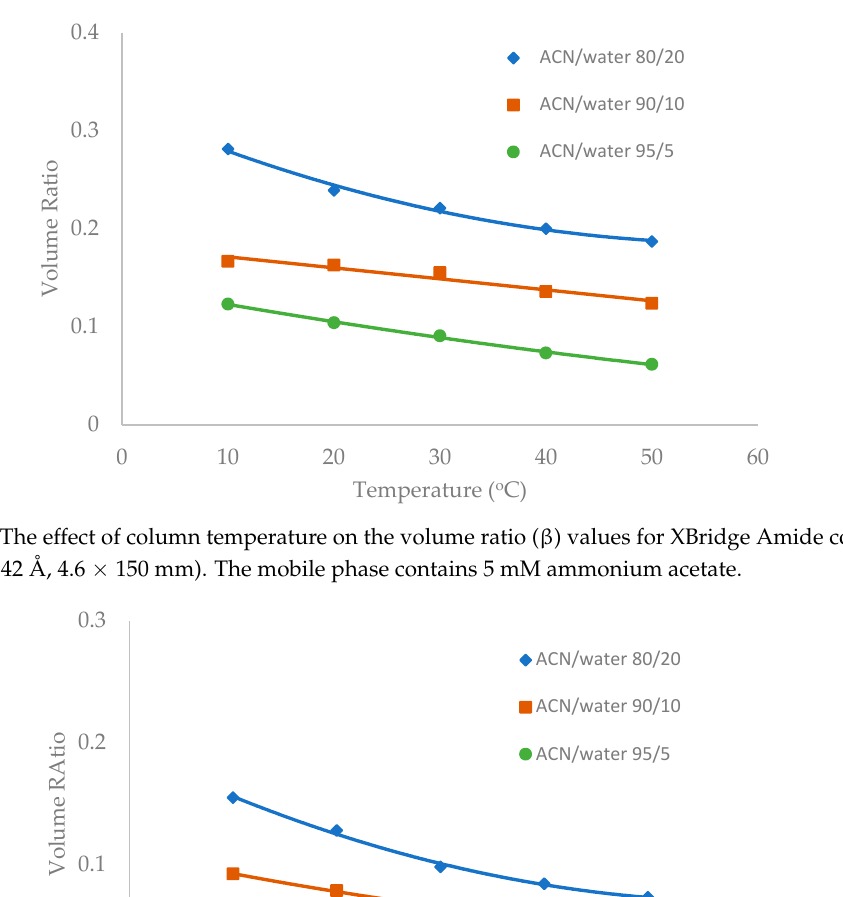
Figure 6. The effect of column temperature on the volume ratio ( β ) values for TSKgel Amide-80 column (3.5 µm, 100 Å, 4.6 × 150 mm). The mobile phase contains 5 mM ammonium acetate.